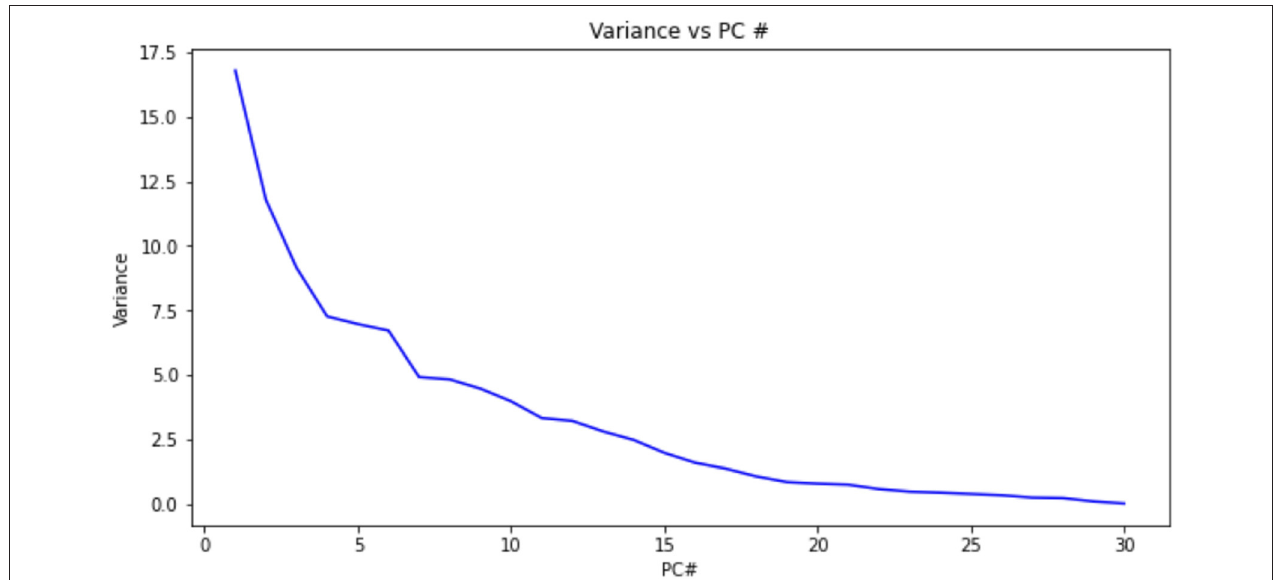
FIGURE 6 | Variance as a function of principal component f(PC#) using the data from Frank et al. (2013). The variance orders the principal components. The cumulative variance reaches a plateau and is a measure of the number of PC’s necessary to contain the information necessary to identify a pattern of finger swiping.